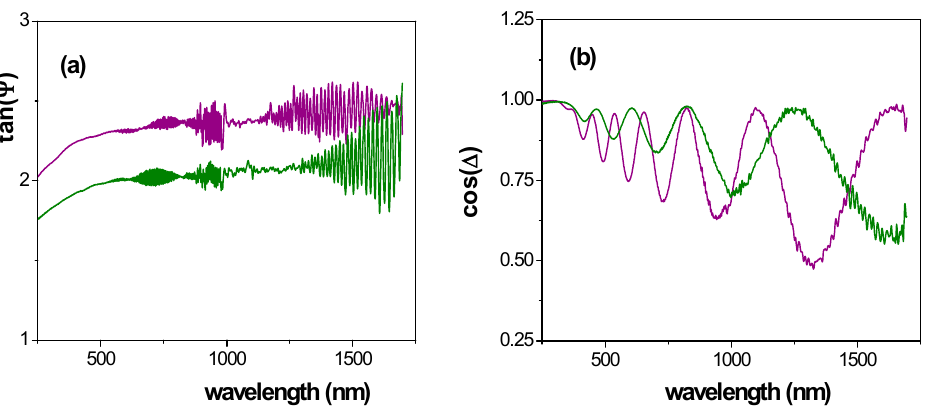
Figure 11. Wavelength dependence of: ( a ) tan Ψ , ( b ) cos ∆ , for Ox–SiO 2 /APTES (green line) and Ox-SiO 2 /APTES/O 3 (purple line) samples.